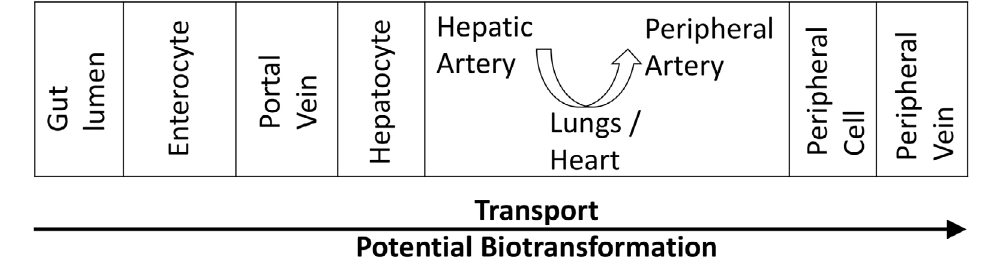
Figure 2. In order for a chemical from the gut lumen to reach a peripheral vein and become available for conventional blood sampling, it must be transported through multiple cells and compartments within which it is vulnerable to